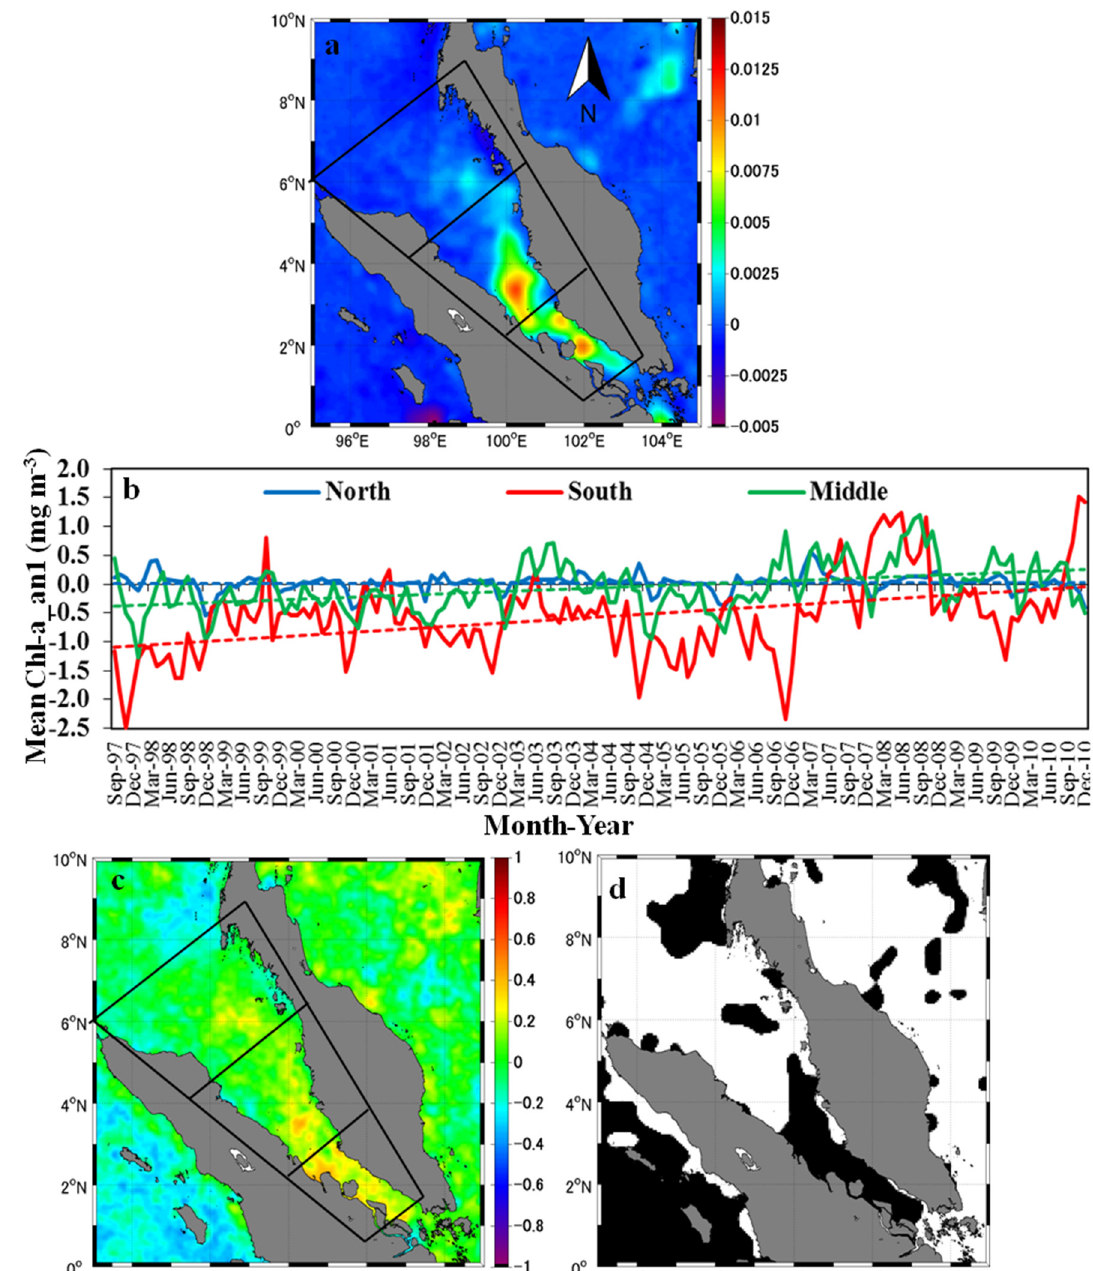
Figure 3. Trends of SeaWiFS Chl- a _an1 (seasonality-removed Chl- a anomalies) during the period of the SeaWiFS full mission depicted as ( a ) a pixel-based trend map (mg∙m −3 ∙month −1 ); and ( b ) spatially averaged time series. Panels ( c ) and ( d ) show the correlation coefficient ( r ) between Chl- a _an1 and time and the corresponding p -value ( p ), respectively. Solid lines in (b) are the regression lines that summarize the Chl- a trends for each region. The metrics of the trends are the regression slopes of 0.007, 0.004 and 0.0001 mg∙m −3 ∙month −1 for the southern, middle and northern regions, respectively. The black area in (d) is the region where the p -value of the correlation coefficient is <0.05; the indication being that the correlation is